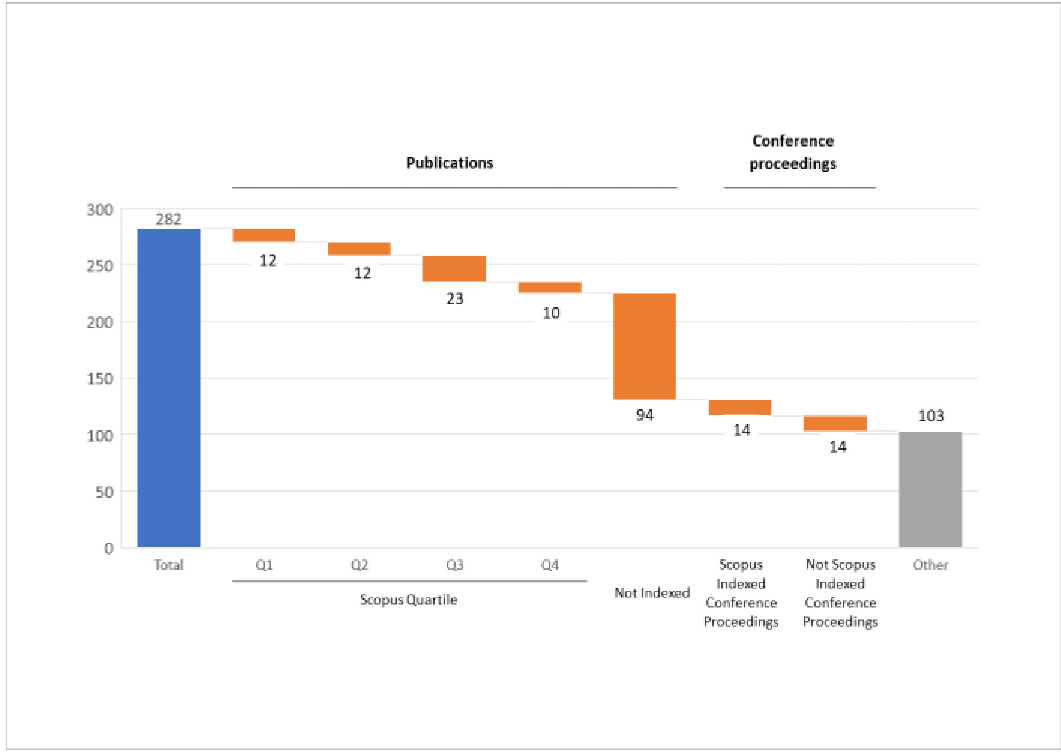
Fig 3. Dataset classification by